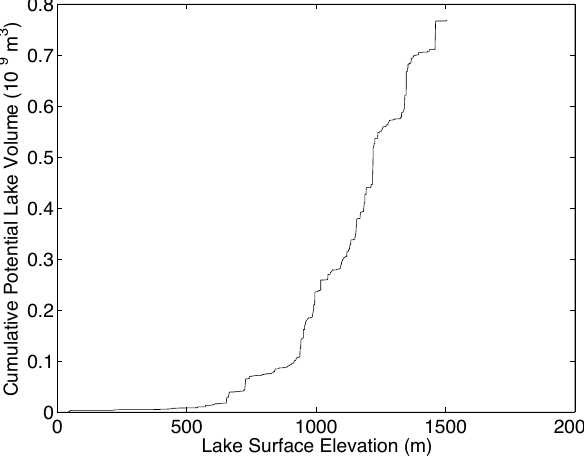
Figure 4. Cumulative maximum potential surface water storage in surface depressions by elevation for the Paakitsoq region. 3